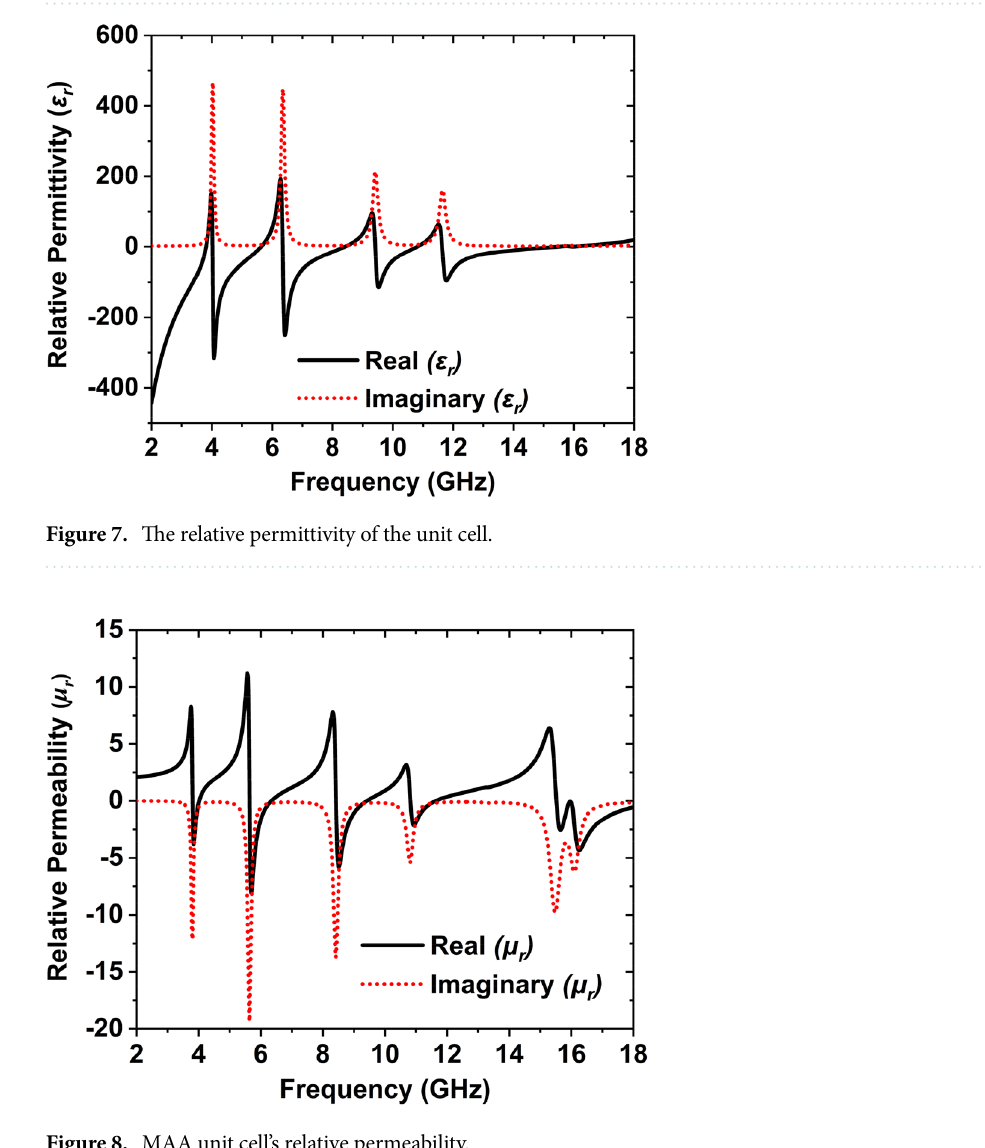
Figure 8. MAA unit cell’s relative